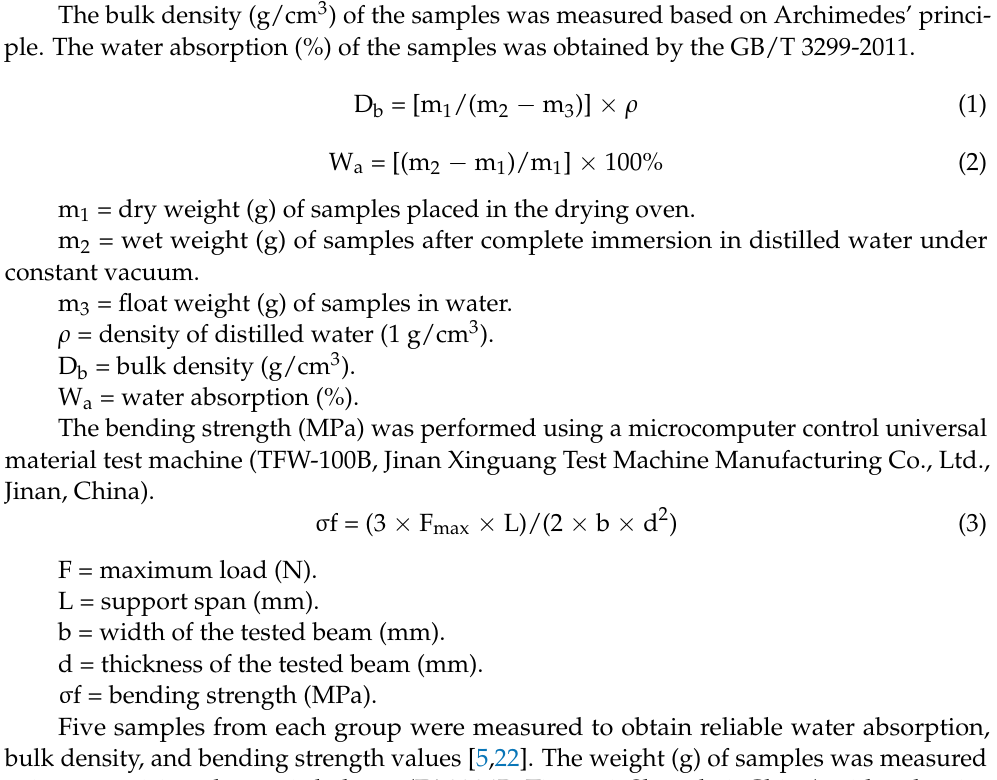
Table 1. Standard formation enthalpy ( ∆ H θ